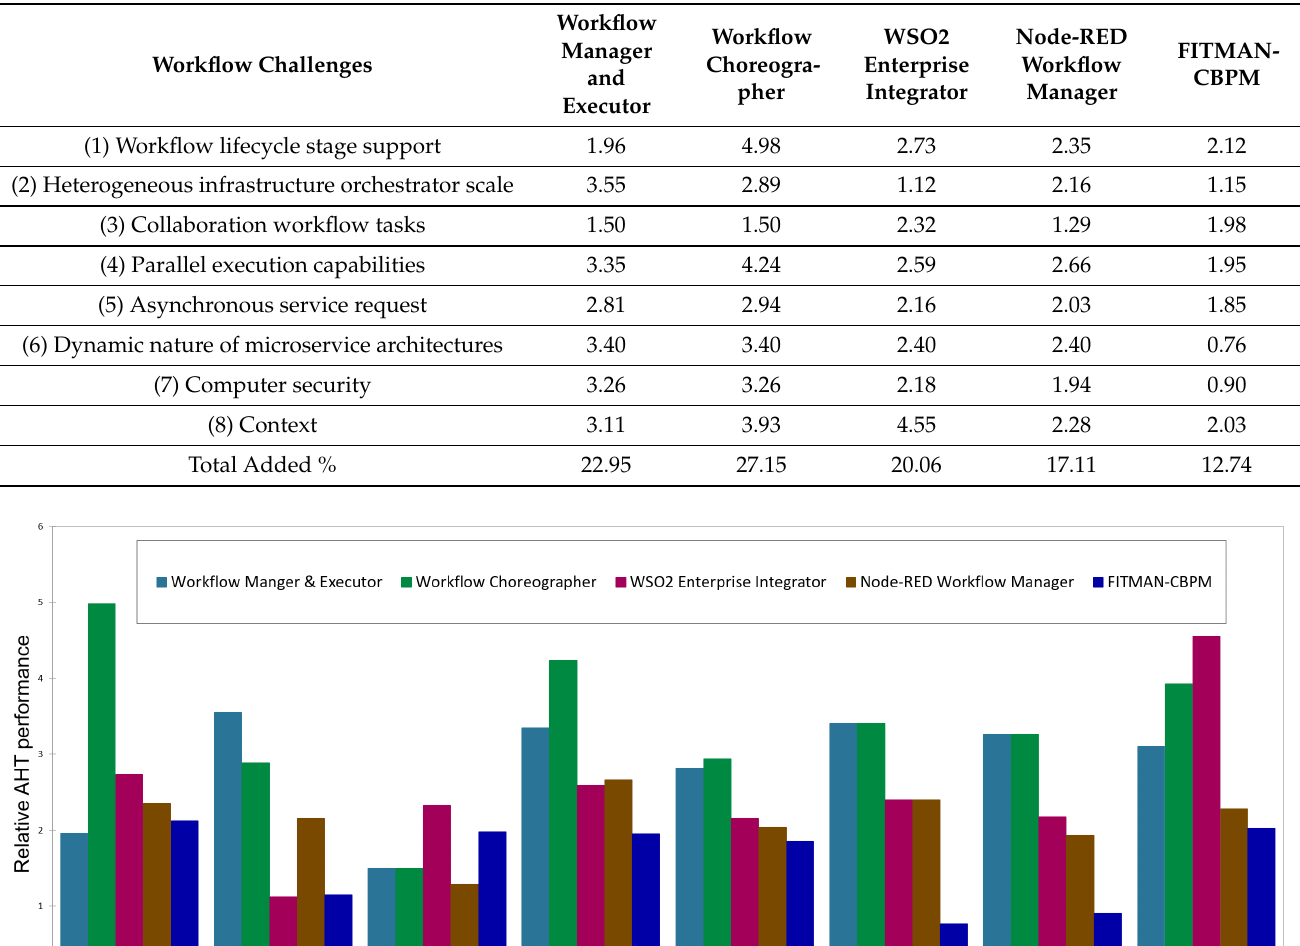
Table 4. Alternative selection by criteria (mean priorities by alternative %).